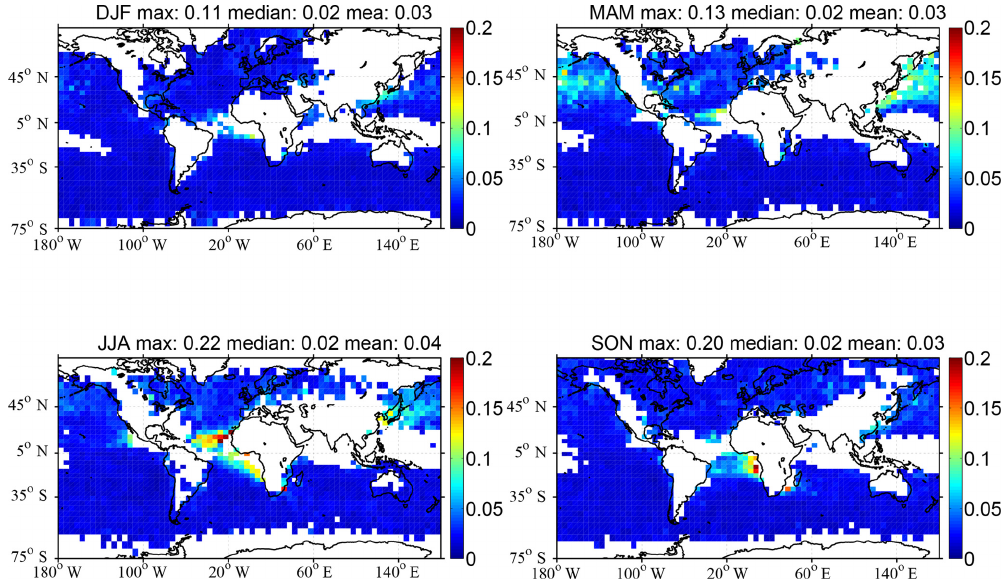
× f AAC from 2008 to 2012. Underlying clouds satisfy the criteria in Table B2. AAC AAC values in the title of each map (i.e., as in Case III AAC values would correspond to Case IV in AAC